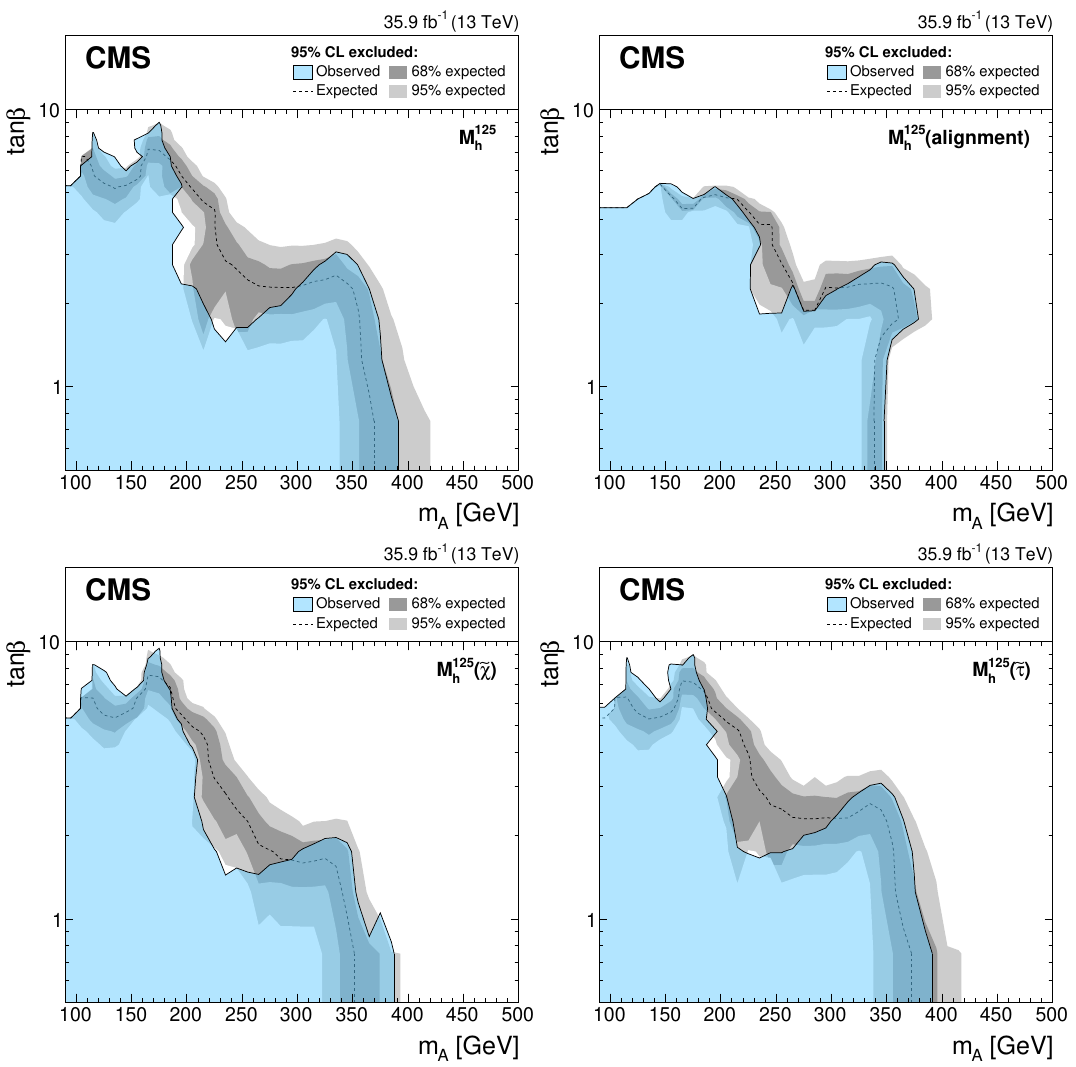
Figure 9 . Expected and observed 95% CL upper limits on tan (cid:12) as a function of m M 125 (upper left), M 125 (alignment) (upper right), M 125 h h scenarios. The expected limit is shown as a dashed black line while the dark and light gray bands indicate the 68 and 95% CL uncertainties, respectively. The observed exclusion contour is indicated by the blue